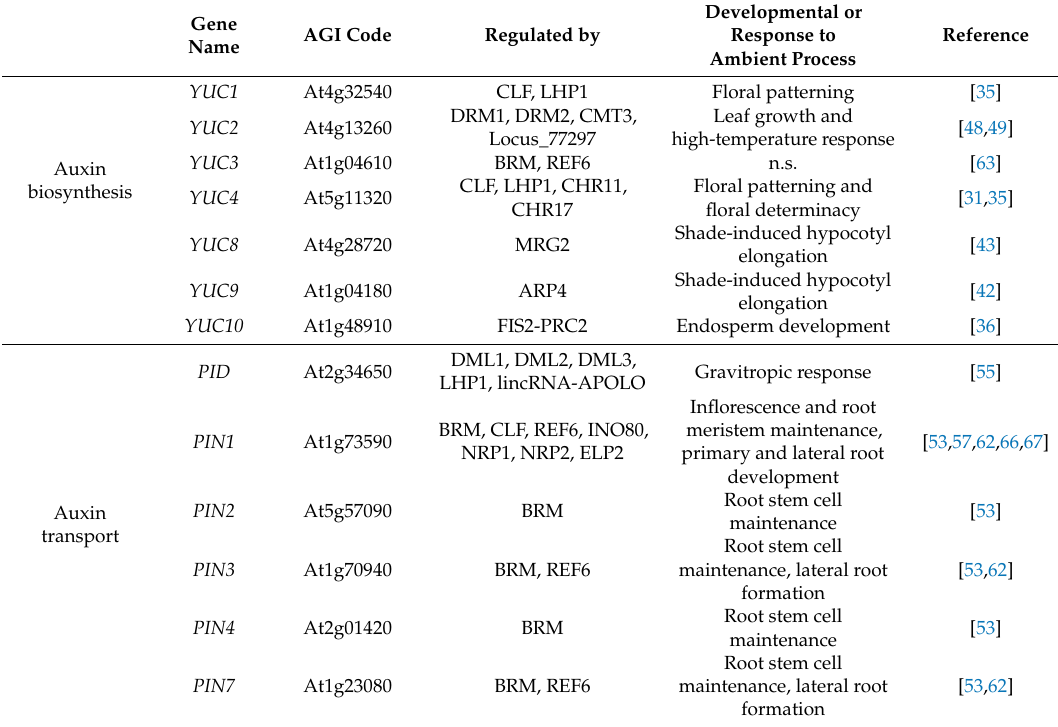
Table 1. Auxin homeostasis-related genes with directly proven epigenetic